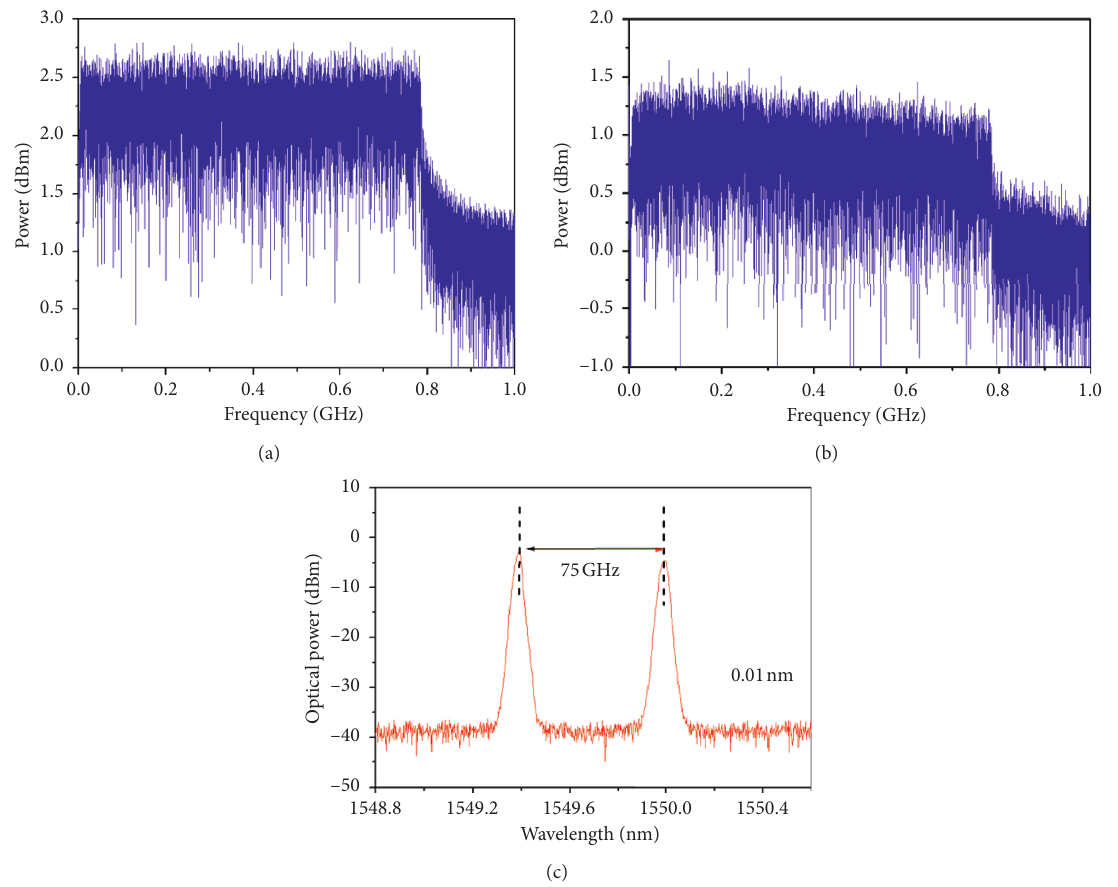
Figure 4: Experimental spectrums. (a) The OFDM signal transmitted after the AWG. (b) The OFDM signal received in the OSC. (c) The coupled optical signal carrying millimeter wave.